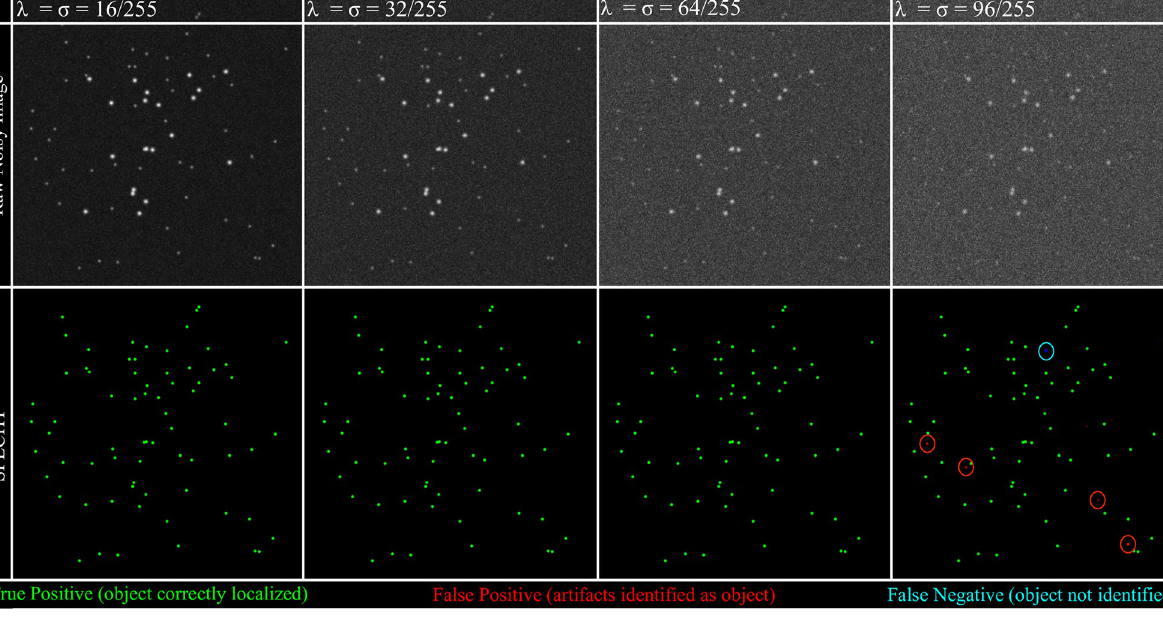
Fig 6. Sensitivity to noise. SNR decreases rapidly as the parameters of both noise sources (Gaussian, Poisson) are increased, yet SPECHT’s recovery of faint objects remains stable under moderate noise conditions. At severe noise levels, as is expected, artifacts appear, while sources with intensity lower than background intensity can no longer be recovered. Green marks true positives, the location of the actual objects. Red marks false positives, predicted objects that do not exist. Blue circles denote false negatives, objects that should be detected, but are